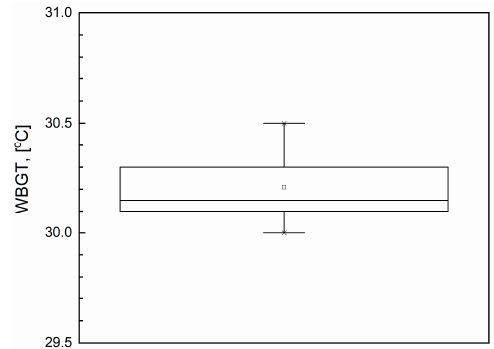
Figure 7. WBGT in the office (east orientation of the glazed facade).